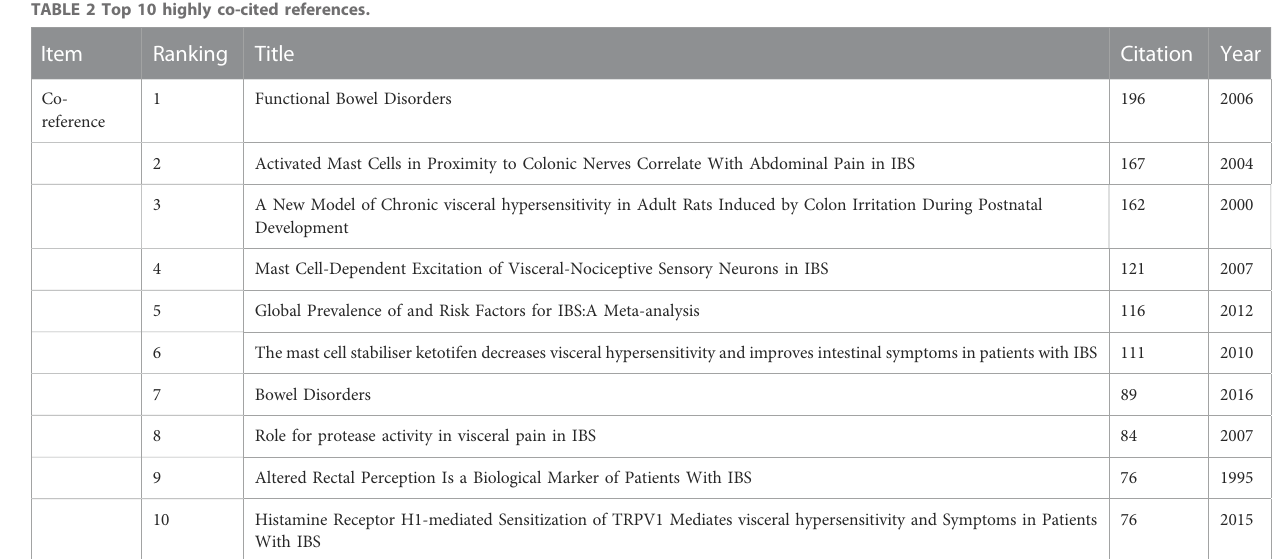
TABLE 2 Top 10 highly co-cited